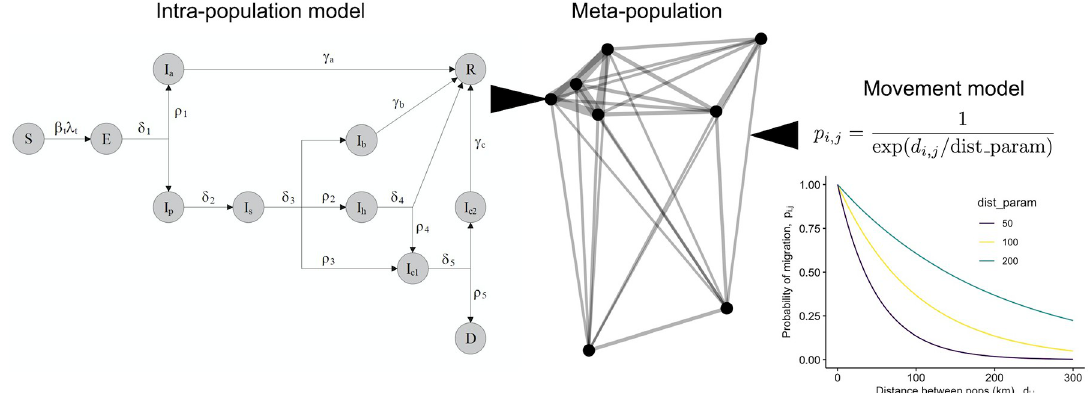
Fig 1. COVID-19 meta-population model schematic. The intra-population model is solved concurrently in each sub-population (node) of the meta-population. The state variables represent transition from Susceptible (S) to Exposed (E) to various Infectious classes (I) (asymptomatic (a), pre-symptomatic (p), symptomatic (s), recovering at home (b), hospitalized (h), in the ICU (c1), in the ICU step- down/recovery unit (c2)) to Recovery (R) or Death (D). Movement of susceptible and infectious host individuals can move the pathogen among sub-populations, and the probability of movement between any two populations p